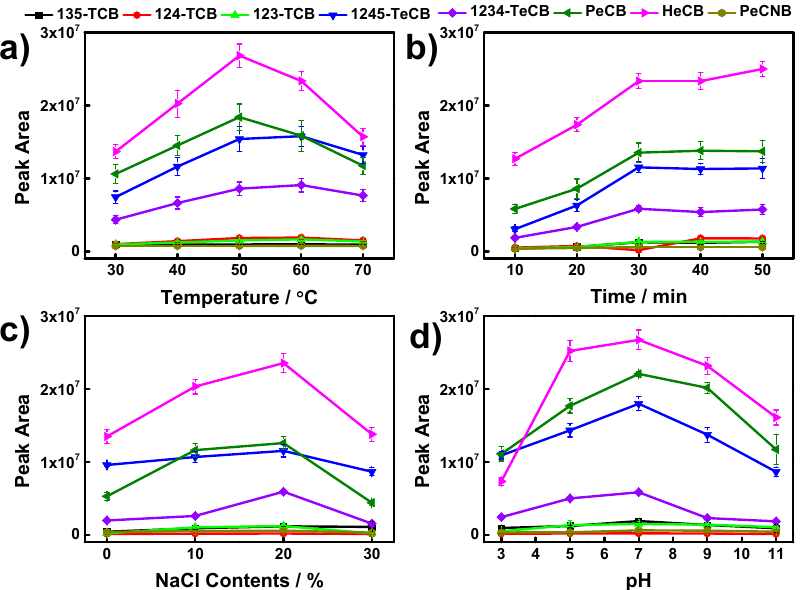
Figure 5. Effect of extraction temperature ( a ), extraction time ( b ), salt concentration ( c ), and pH ( d ) on the extraction efficiencies of the CDs/g-C 3 N 4 SPME coating for CBs. Error bars represent the standard deviation of the mean ( n = 3).